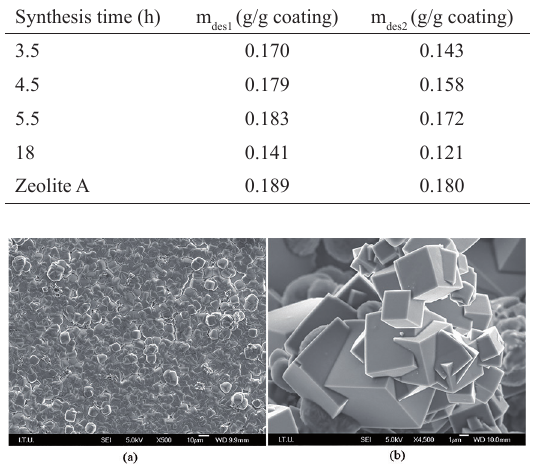
Figure 3: FEGSEM micrographs of the coating grown from composition